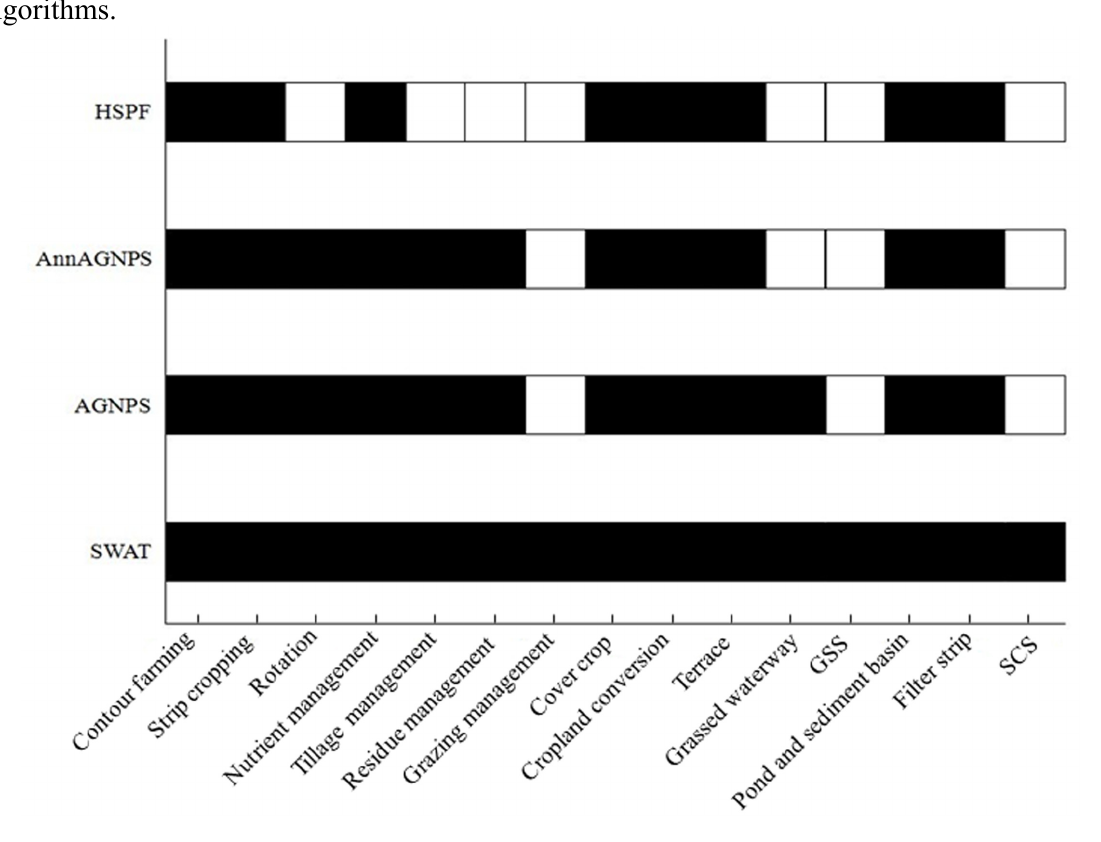
Figure 1. Typical agricultural BMPs which can be assessed by each watershed model. (Black squares indicates that the model can address those BMPs and white squares indicates the opposite. GSS: Grade stabilization structure. SCS: Stream channel